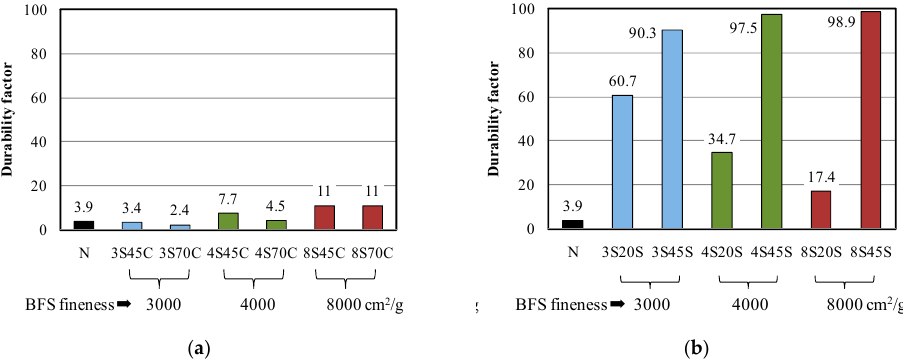
Figure 5. Durability factors for different mortar mixtures with or without BFS during freeze–thaw cycles: ( a ) replacement by BFS for cement and ( b ) replacement by BFS for sand.